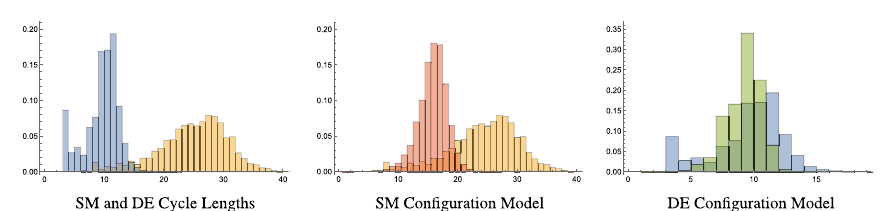
Fig. 3 Left: Shown in orange is the distribution of the lengths of the cycles forming a basis of the nonfamilial cycle lengths in the San Marino (SM) genealogical network. The analogous distribution of cycle lengths is shown in blue for all cycles in the Deezer Europe (DE) social network. Center: Shown in orange is again the basis cycle length distribution of the San Marino genealogical network. In red is the distribution of the basis cycle lengths averaged over ten realizations of the (loopy, multi-edged) configuration model on the San Marino network. Since the configuration model generates graphs with the same degree distribution as the SM network, this panel indicates that SM’s longer cycles do not arise simply from the degree distribution. Right: Shown in blue is again the basis cycle length distribution of the Deezer social network. In green is the distribution of the basis cycle lengths averaged over ten realizations of the configuration model on the Deezer social network. For this social network, the cycle length distribution can be mostly explained by the degree distribution